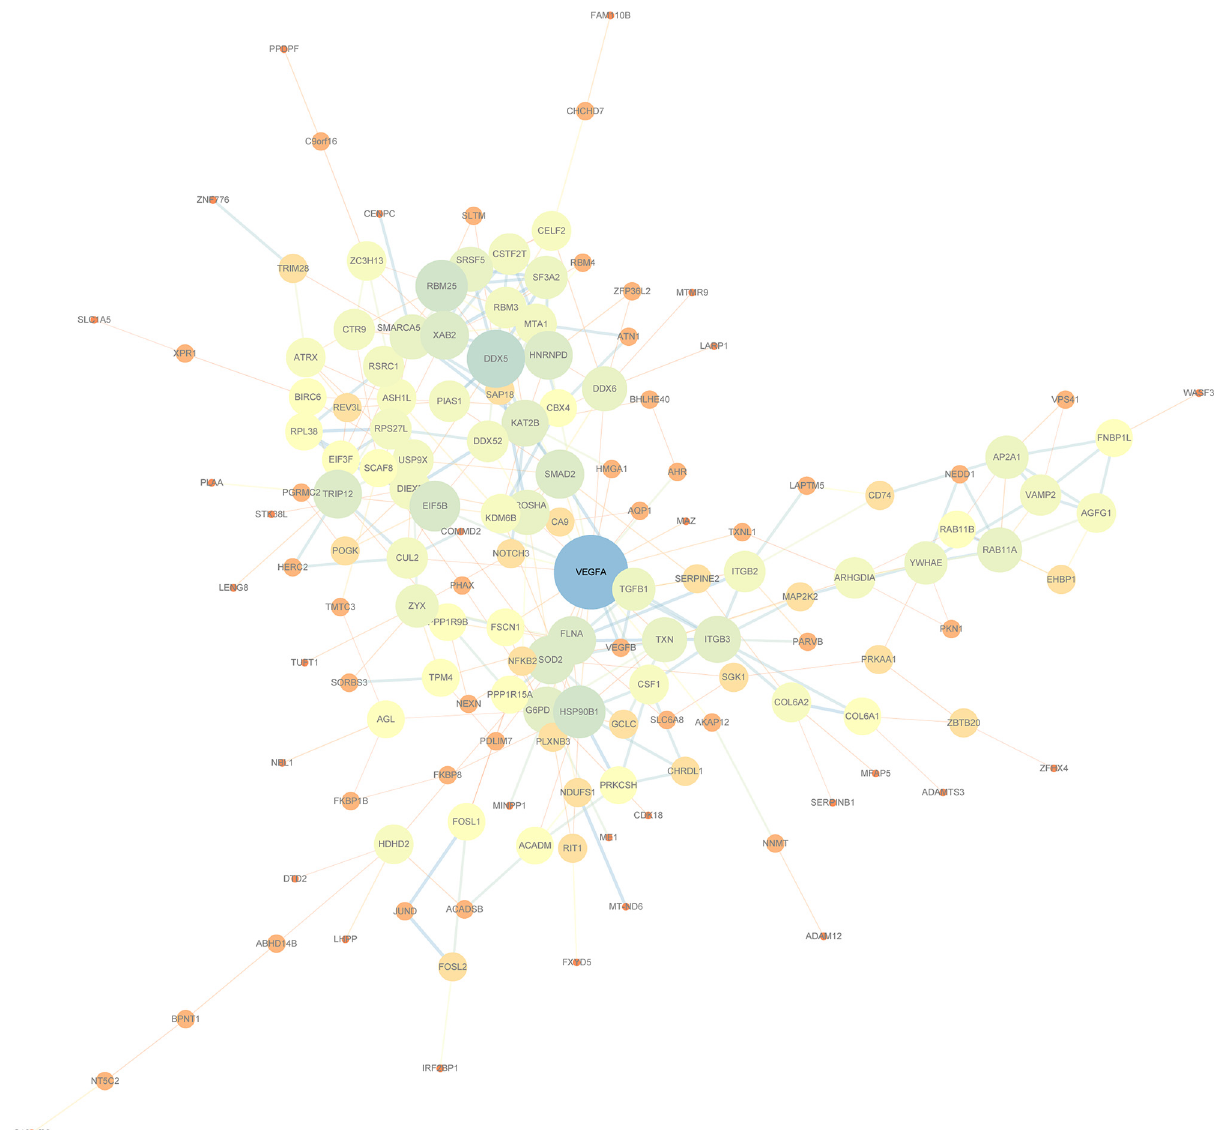
Figure 7: PPI diagram of STRING protein network visualized by